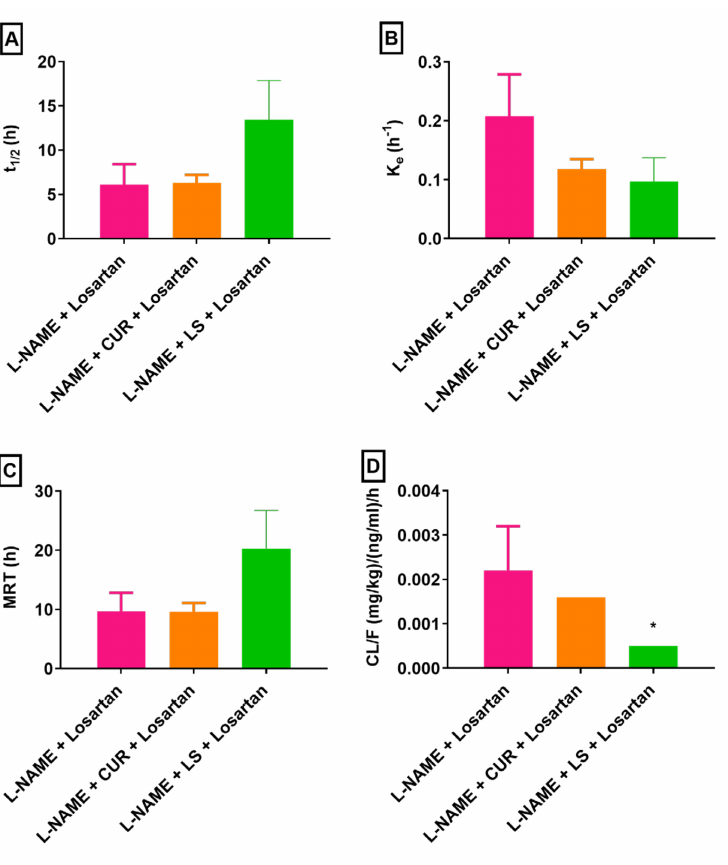
Figure 5. Pharmacokinetic parameters ( A ) t 1/2 , ( B ) K e , ( C ) MRT and ( D ) CL/F of losartan alone and in presence of CUR and LS following an oral administration in hypertensive rats ( n = 5. mean ± SEM). L-NAME, “N-nitro l-arginine methyl ester”; CUR, Curcuma longa ; LS, Lepidium sativum . * p < 0.05 as compared to L-NAME +